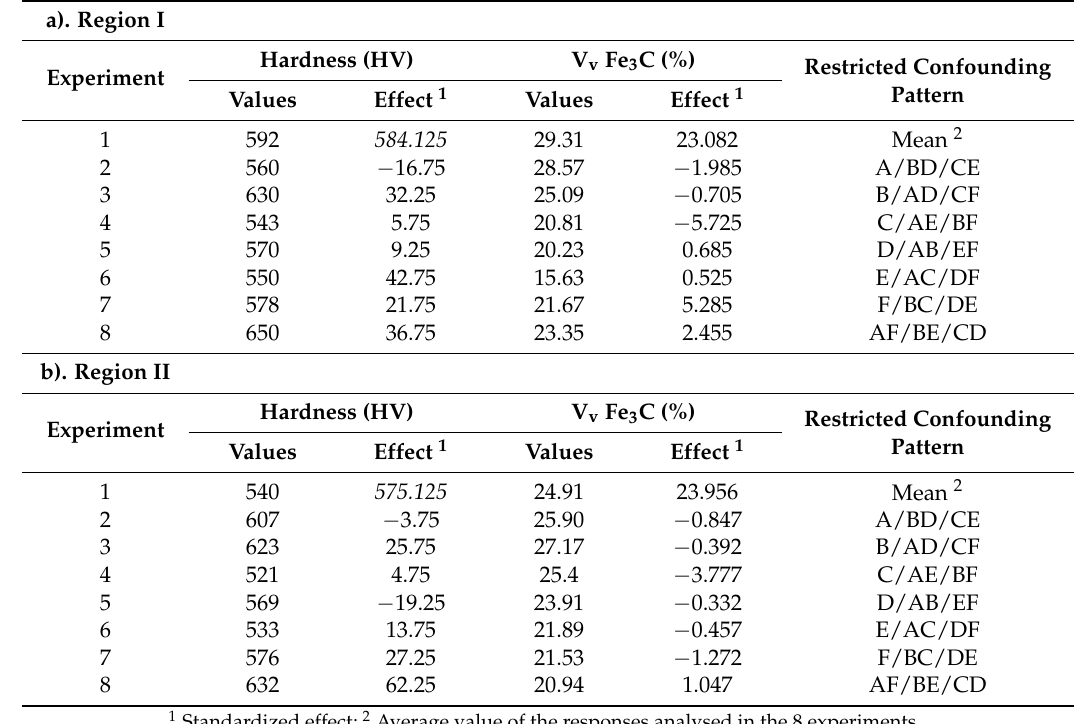
Table 9. Average values and standardized effects for the volume fraction of cementite and Vickers hardness. a). Region